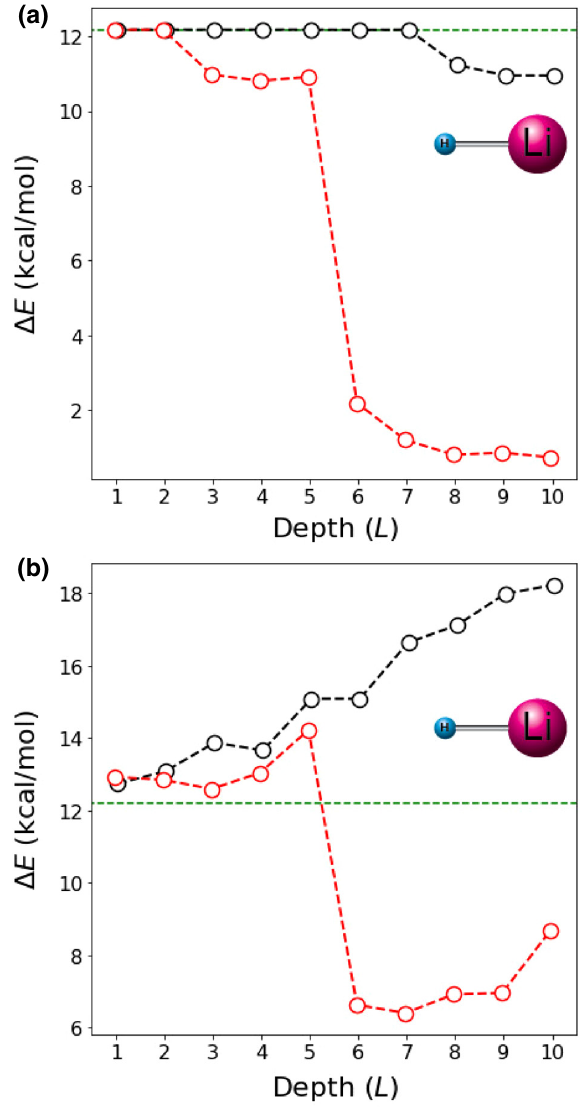
FIG. 8. Energy error (cid:7) E = E VQE − E exact versus Ry ansatz depth L for the ten-qubit LiH in the STO-3G basis in a reduced active space based on default (black) and permuted qubit Hamil- tonians (red) built from approximate wave functions (up to three PermVQE iterations are used to build the best entanglement maps). Results are based on (a) a state vector (noiseless) sim- ulator and (b) the Qasm (noisy) simulator. Dotted green lines correspond to pseudo-correlation energy defined as (cid:7) E PC = E HF − E exact